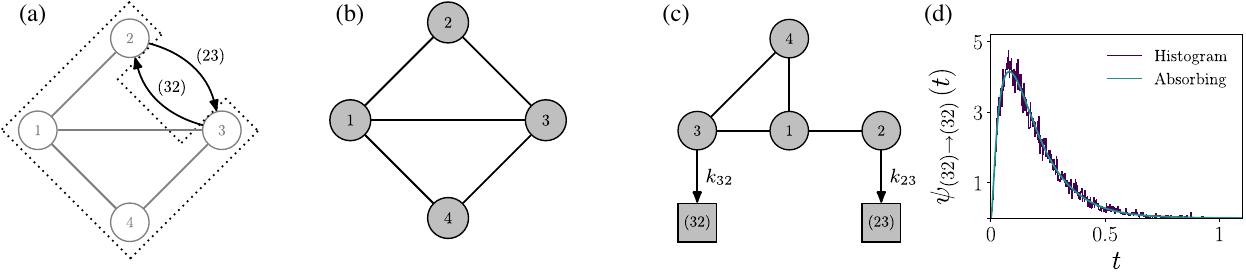
FIG. 5. Example for the analytical calculation of waiting time distributions based on effective absorbing dynamics. (a) Effective description for the partially accessible two-cycle network from the main text. Only transitions from state 2 to state 3 and in the reversed direction are observable. (b) Underlying Markov network. On the fundamental level of description, the network is Markovian, and transitions from state k to state l are governed by the transition rate k kl . (c) Effective absorbing Markov network. Between two observed transitions, the system can be described with an absorbing master equation. This intermediate hidden dynamics is terminated by either a transition (32) or a transition (23). (d) Exemplary waiting time distribution derived from the numerical solution of the absorbing master equation for theeffectivedynamics andthe correspondingdistributiondetermined from ahistogram ofthewaiting times withina trajectory of length T ¼ 10 7 generated with a Gillespie simulation [75] of the network. The transition rates of the network are drawn